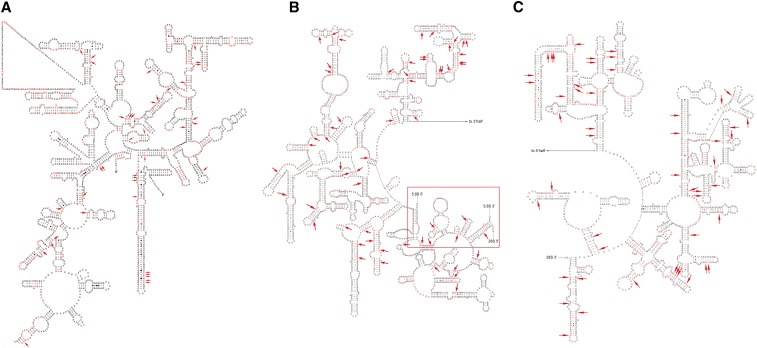
(A) Secondary structures of 18S rRNA gene, (B) 5′ half of 28S rRNA gene with 5.8S rRNA binding on it (marked in red frame), and (C) 3′ half of 28S rRNA gene. Structural diagrams were drawn with a GenBank sequence of N. crassa (accession number FJ360521). The 5.8S rRNA is shown in red frame. Observed mutated base pairs in pseudogenes were marked in red. Mutations which would probably destroy the secondary structures were marked with red ↓.